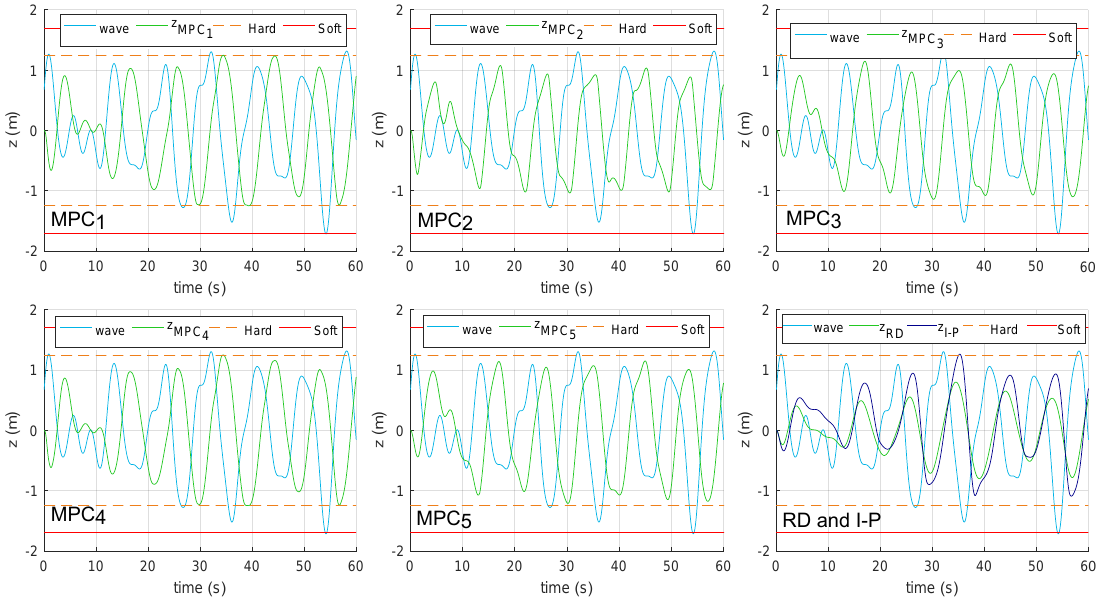
Figure 6. Simulation of the positions obtained in the WEC system when applying the seven controllers to the mathematical model (15).